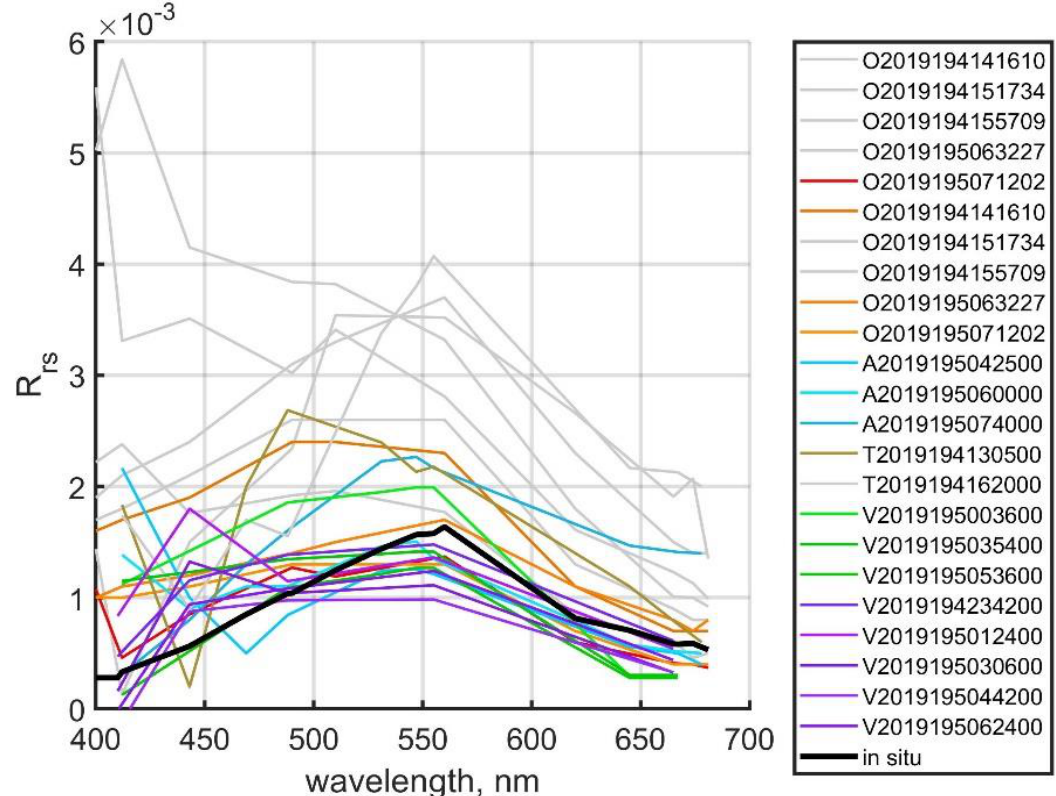
Figure 8. R rs ( λ ) values obtained from the shipboard (black line) and satellite measurements (colored lines: red — OLCI BAC, orange — OLCI AAC, blue — MODIS Aqua, brown — MODIS Terra, green — VIIRS SNPP, purple — VIIRS NOAA-20). The grey color shows data for which the RMSE values obtained by comparing shipboard and satellite data were greater than 0.001. Station 6240, Kara Sea, July 14, 2019.